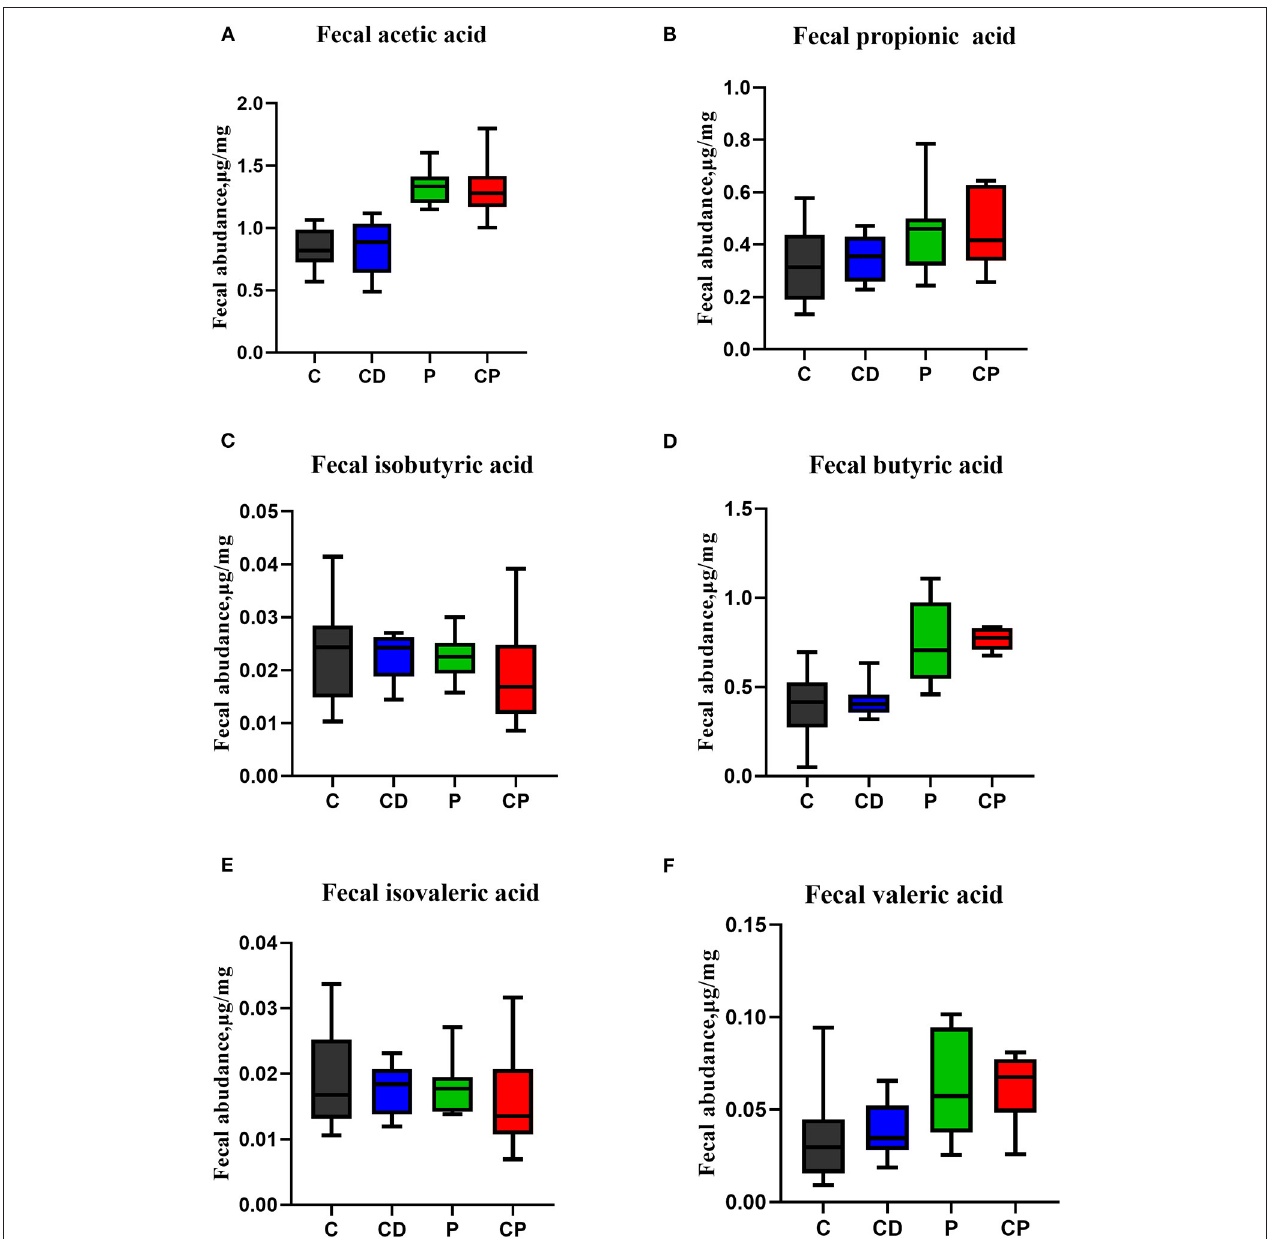
FIGURE 9 | The effect of chenpi on short-chain fatty acids (SCFAs) in the feces ( n = 9–10). (A) Acetic acid, (B) propionic acid, (C) isobutyric acid, (D) butyric acid, (E) isovaleric acid, and (F) valeric